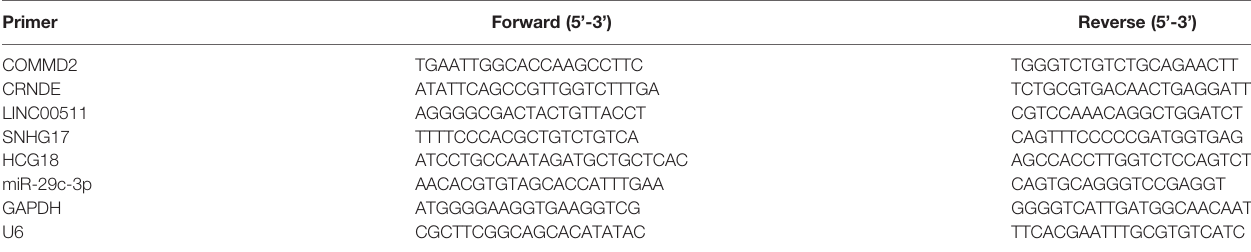
TABLE 1 | Primers used in the